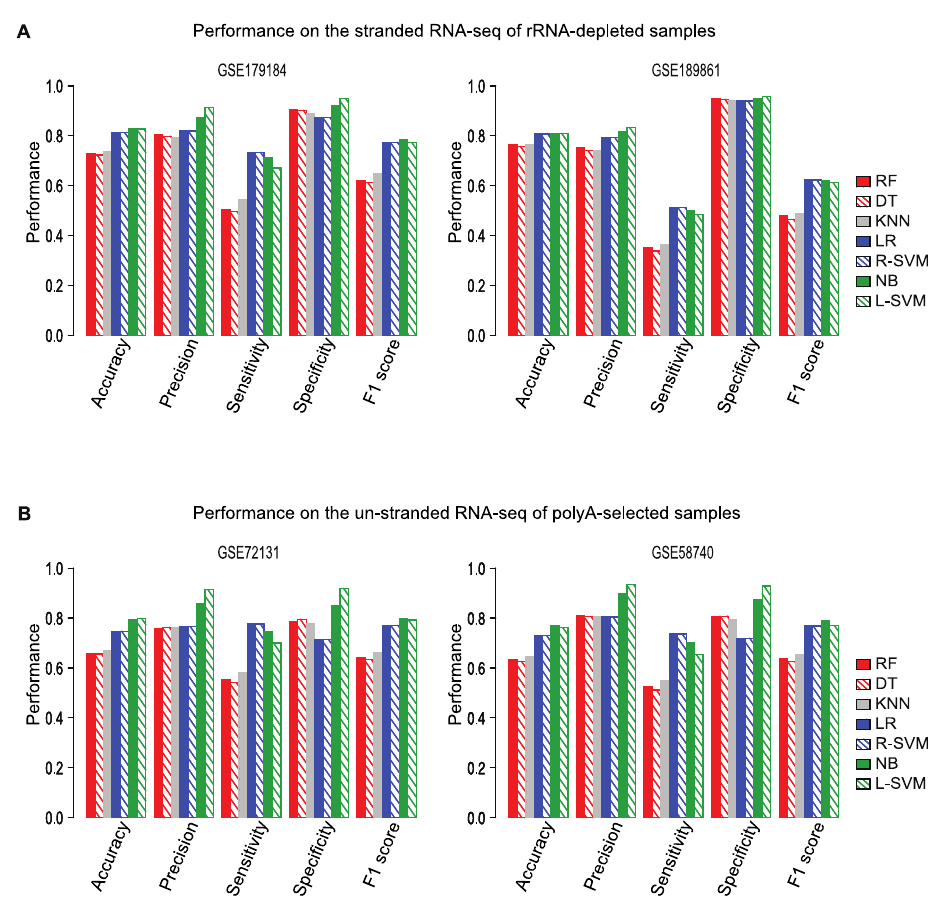
Figure 5. Flnc accurately identifies true lncRNAs from rRNA-depleted and unstranded RNA-seq datasets. ( A ) Performance of Flnc on two stranded RNA-seq datasets generated from ribosomal RNA (rRNA)-depleted samples (GSE179184 on the left, GSE189861 on the right). ( B ) Performance of Flnc on two un-stranded polyA-selected RNA-seq datasets (GSE72131 on the left, GSE58740 on the right).